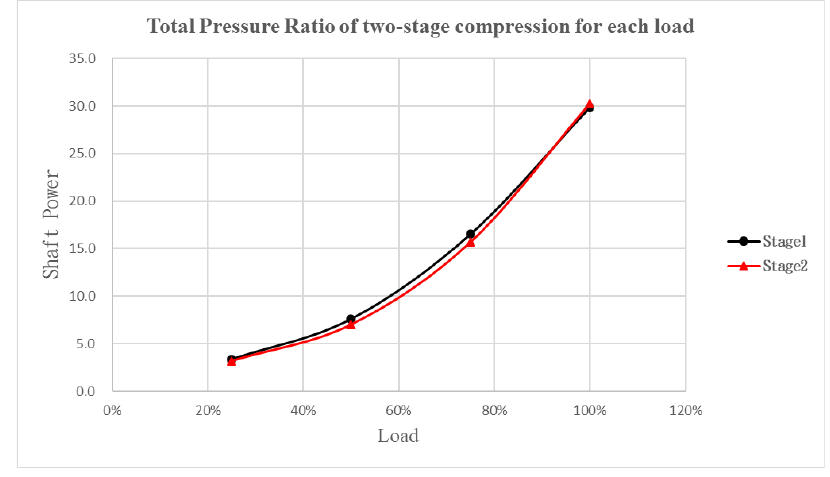
Figure 10. R-513A refrigerant two-stage compression shaft power comparison diagram under vari- ous loads.